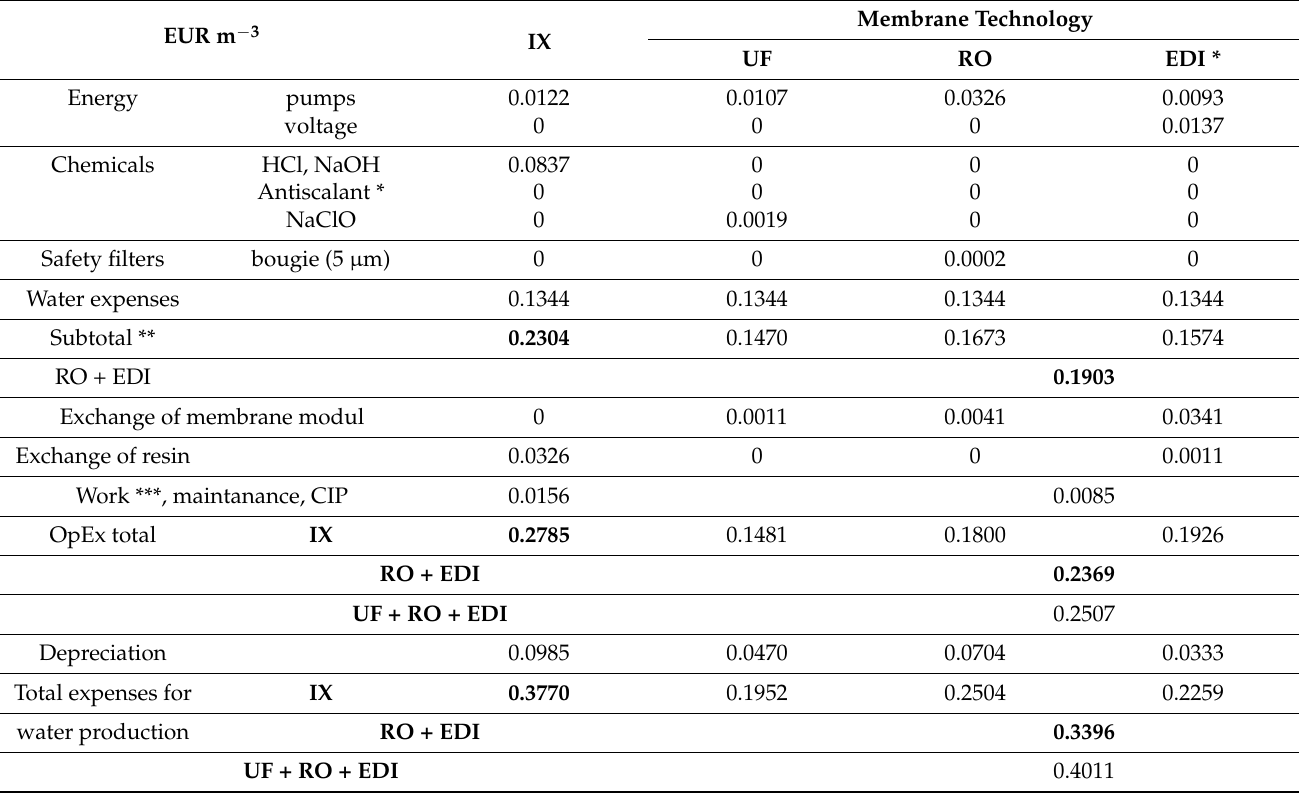
Table 5. Exact entries of membrane and IX technologies from Figure 6.